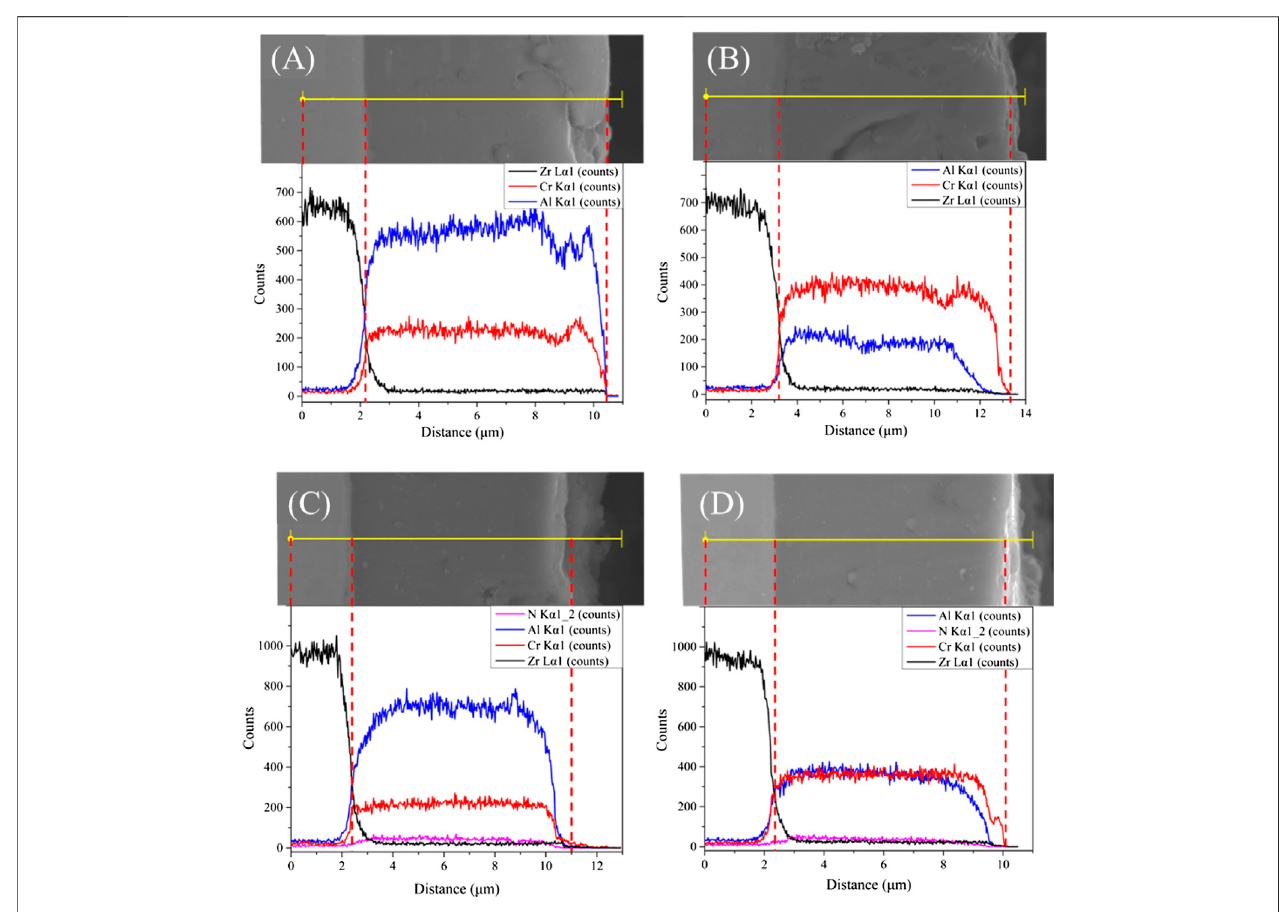
FIGURE 9 | EDS results of cross-section of each ATF candidate cladding with 2 h deposition: (A) Cr 32.1 Al 67.9 , (B) Cr 45.8 Al 54.2 , (C) Cr 32.1 Al 67.9 N, and (D) Cr 45.8 Al 54.2 N.